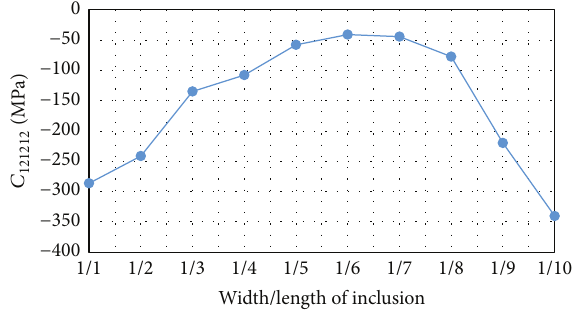
Figure 8: Dependence of coefficient versus form of reinforcing wires cross section.